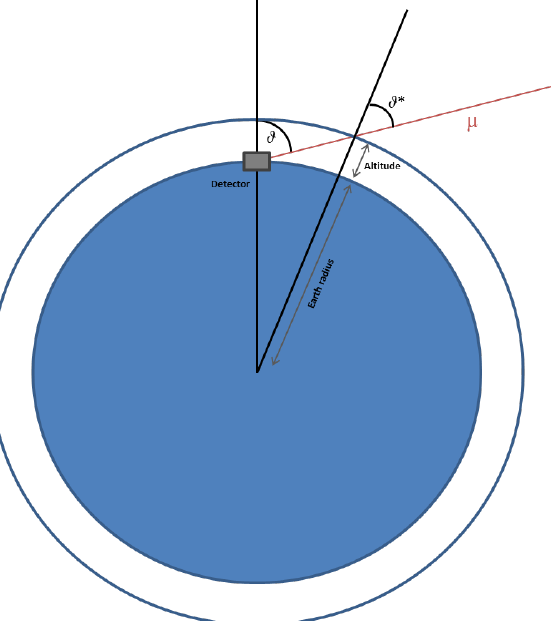
Figure 2. The angles θ and θ ∗ formed by an incoming muon, respectively, with the normal axis to the earth surface and with the normal axis to the top of the